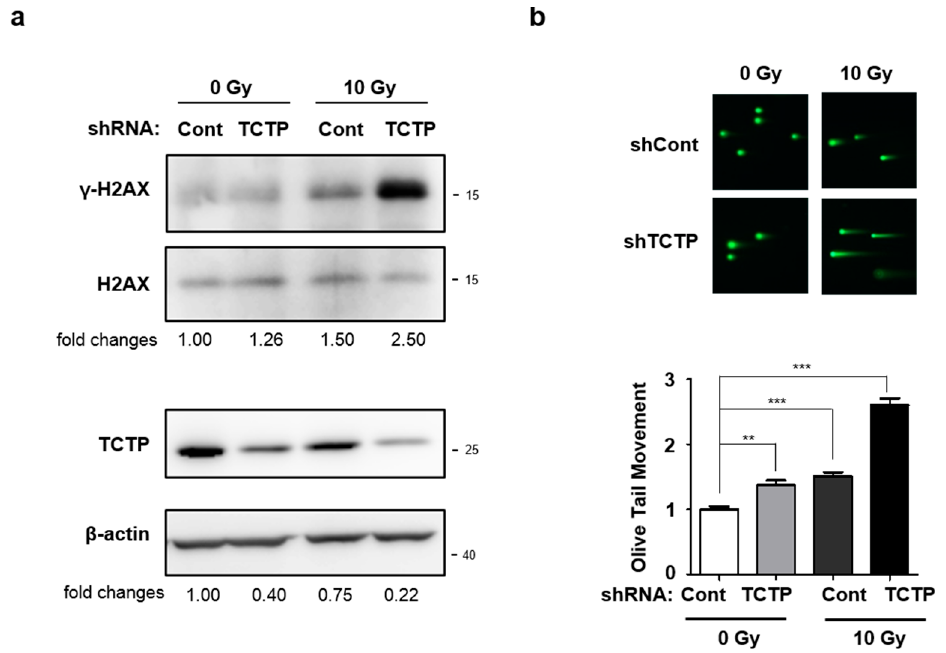
Figure 4. TCTP knockdown potentiates radiation-induced DNA damage in A549 cells. ( a ) After 48 h γ -radiation, γ -H2AX, H2AX, and TCTP expression level of A549 cells transfected with TCTP shRNA (shTCTP) and control shRNA (shCont) were measured using Western blot analysis ( n = 4). The cropped blots are used in the figure and full-length blots are presented in Figure S8. The relative level of TCTP to β -actin and γ -H2AX to H2AX are indicated below each immunoblot image. ( b ) TCTP-depleted A549 cells were treated with 10 Gy of γ -radiation and comet assay was performed after 48 h. The olive tail moment was calculated using the Comet 5.5 software. The data represent the mean ± SEM. ** p < 0.01, *** p < 0.001 by one-way analysis of